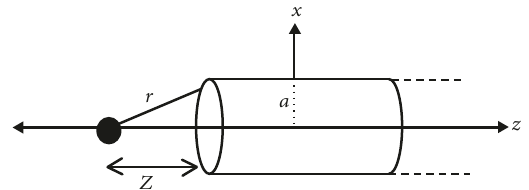
Figure 1: Schematic illustration of a Ni atom entering a single- walled